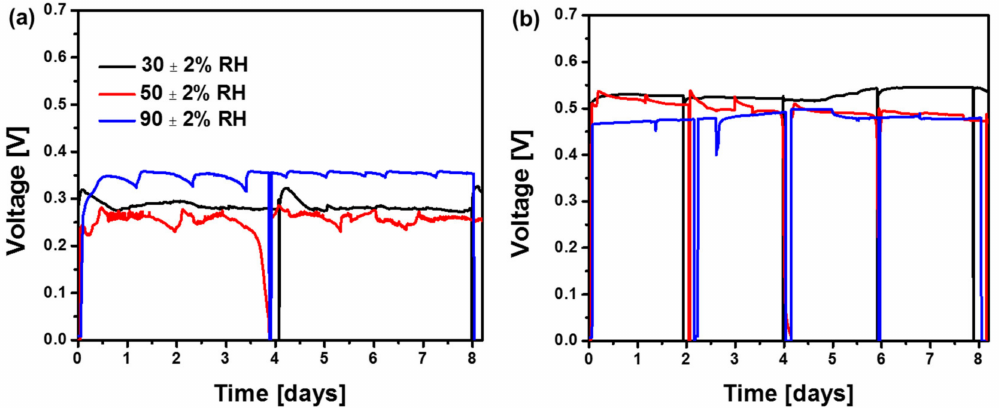
Figure 2. Voltage generation from a single chamber air cathode MFC at di ff erent relative humidity (RH: 30 ± 2%, 50 ± 2% and 90 ± 2%) conditions with ( a ) Nafion 117 and ( b ) PP80 as a